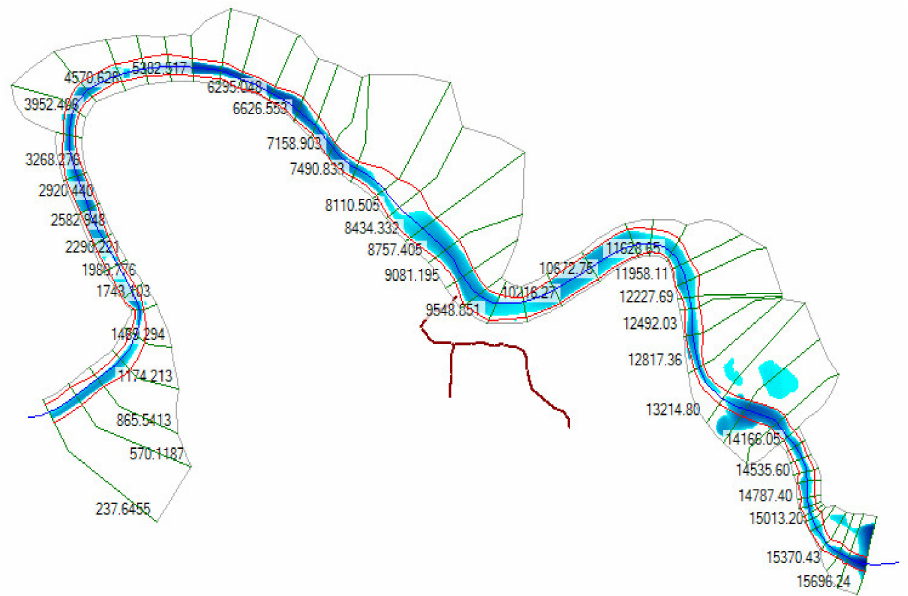
Figure 4. One-dimensional (1D) river reach with cross-sections. Water shown in blue: darker blue representing deeper water.